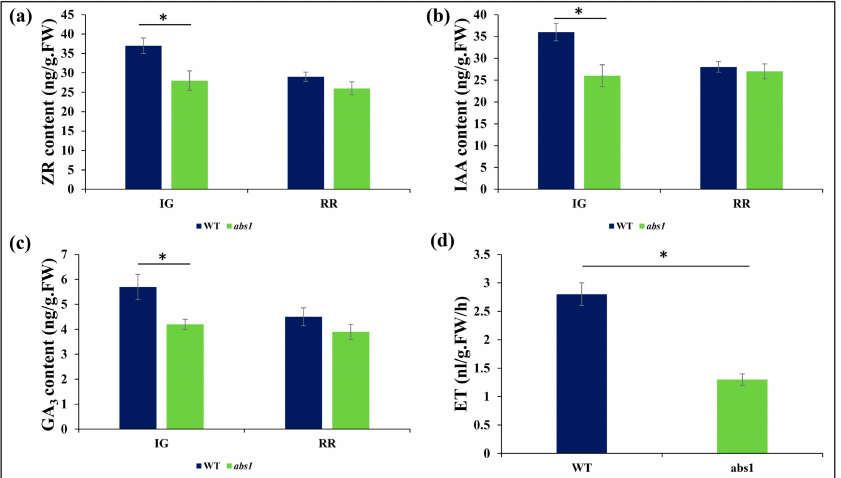
Figure 3. Endogenous quantification of phytohormones. ( a ) ZR, ( b ) IAA, ( c ) GA 3 , and ( d ) ET (RR stage) in WT and abs1 mutant fruits at immature green (IG) and red ripe (RR) stages. The error bar represents standard error. Asterisks indicate significant differences (*: p ≤ 0.05, Student’s t